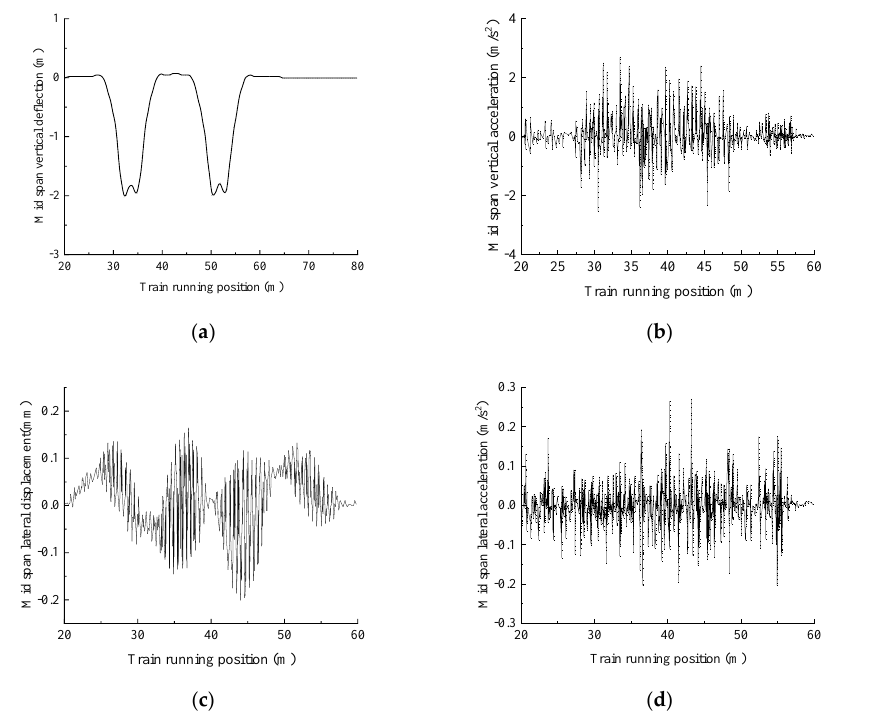
Figure 14. I Overhead system dynamic response: ( a ) Mid − span vertical deflection (unit: mm). ( b ) Mid − span vertical acceleration (unit: m/s 2 ). ( c ) Mid − span lateral displacement (unit: mm). ( d ) Mid − span lateral acceleration (unit: m/s 2 ).